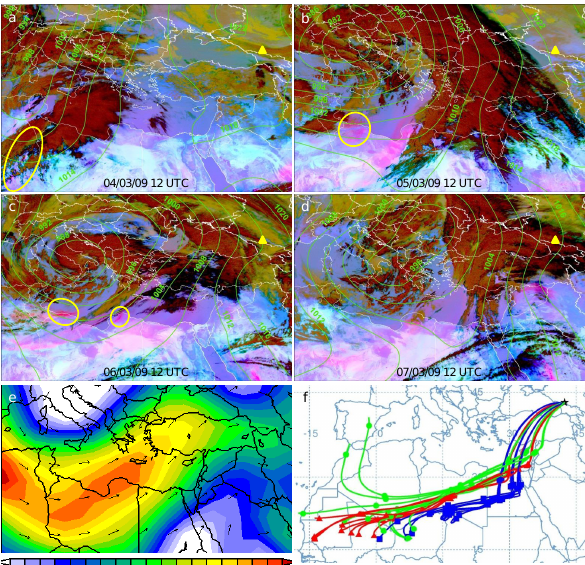
Fig. 5. (a–d) SEVIRI-derived RGB false colour composite im- ages for 4–7 March 2009, showing dust (pink/magenta), clouds (brown/orange), and differences in surface emissivity retrieved in absence of dust or clouds (blue). Deserts appear as light green- blue. Isobars are shown as continuous green lines with SLP values (hPa). (e) Five-day (4–8 March 2009) average wind speed (ms − 1 ) and direction at 700hPa. (f) 4-days three-dimensional back tra- jectories from HYSPLIT model starting at 43.348 ◦ N; 42.427 ◦ E; 5000ma.s.l. at 22:00UTC on 7 March 2009. Mt. Elbrus is shown as a yellow triangle. The yellow ovals highlight areas of dust